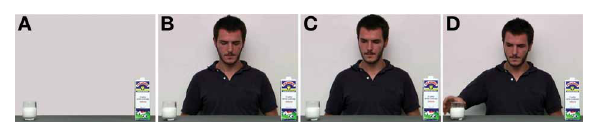
FIGURE 1 | Final frames for the four videos used in Experiment 1. In the No Actor video (A) no actor model was present. In the Actor video (B) the actor was stationary and looked down, seemingly unaware of the objects on the table. In the Gaze video (C) the actor turned his head to look toward, but did not reach for the glass. In the Gaze Action video (D) the actor turned the head to look toward and reached for the glass.